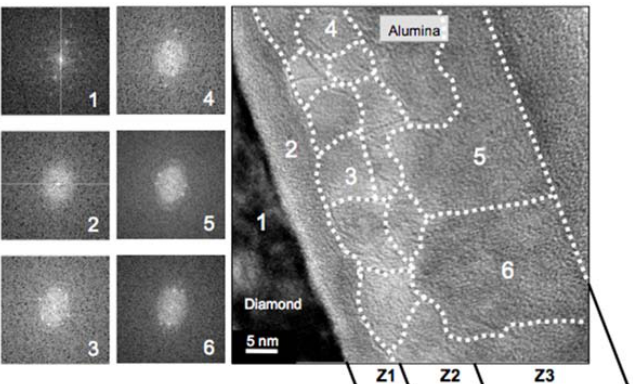
Figure 3. Low magnification HREM micrograph of sample B. On the left side the Fast Fourier transforms (FFTs) from six areas (labeled from 1 to 6) of the micrograph on the right are showed as an example of all those obtained on the whole micrograph. Three zones, labeled Z1, Z2, and Z3, are identified. Z1 corresponds to amorphous alumina (FFT 2), while Z2 and Z3 correspond to polycrystalline cubic alumina (FFT 3, 4, 5 and 6) where dashed white lines are used to delimit grains with different orientations.